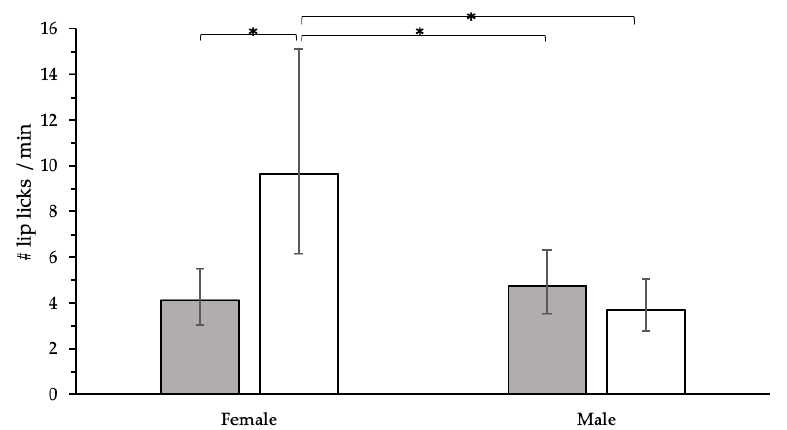
Figure 4. Interaction between training and dog sex from a mixed Poisson regression model displaying di ff erences in lip lick rate (95% CI) during the post-treatment examination between control (gray) and training (white) treatment groups; * p <